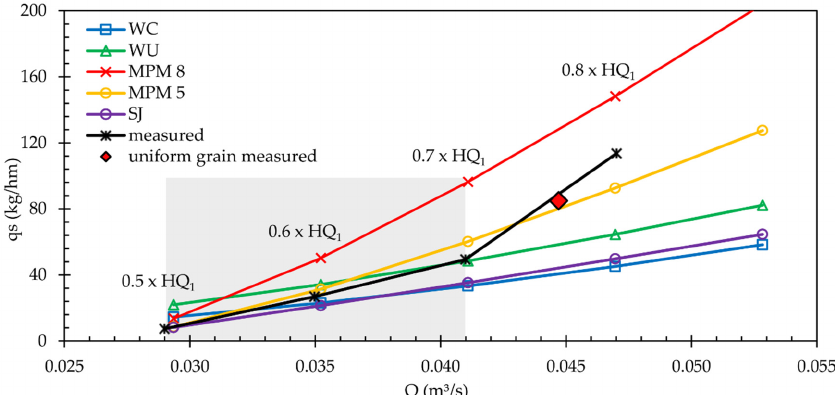
× HQ × HQ 1 –0.9 1 : calculated sediment